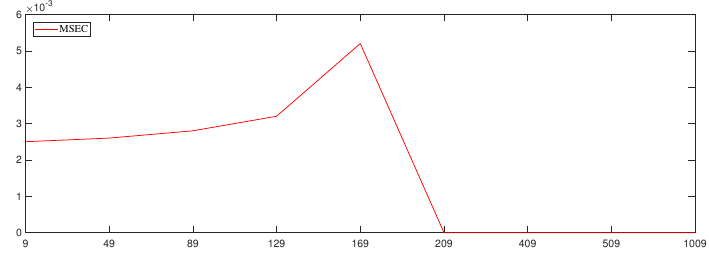
Figure 8. Folding line plot of the mean square error for a variance of 1.